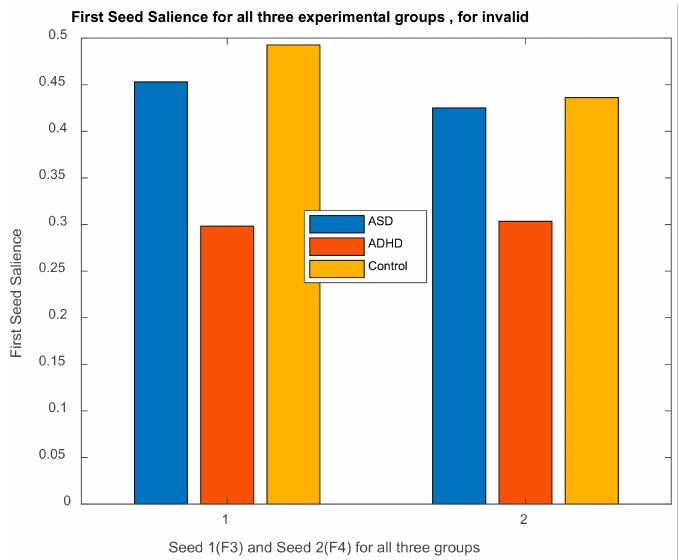
Figure 28. Plot of first seed salience, vs. seeds 1 and 2 (MSE values at F3 and F4, respectively), for all groups, in the invalid syllogism.